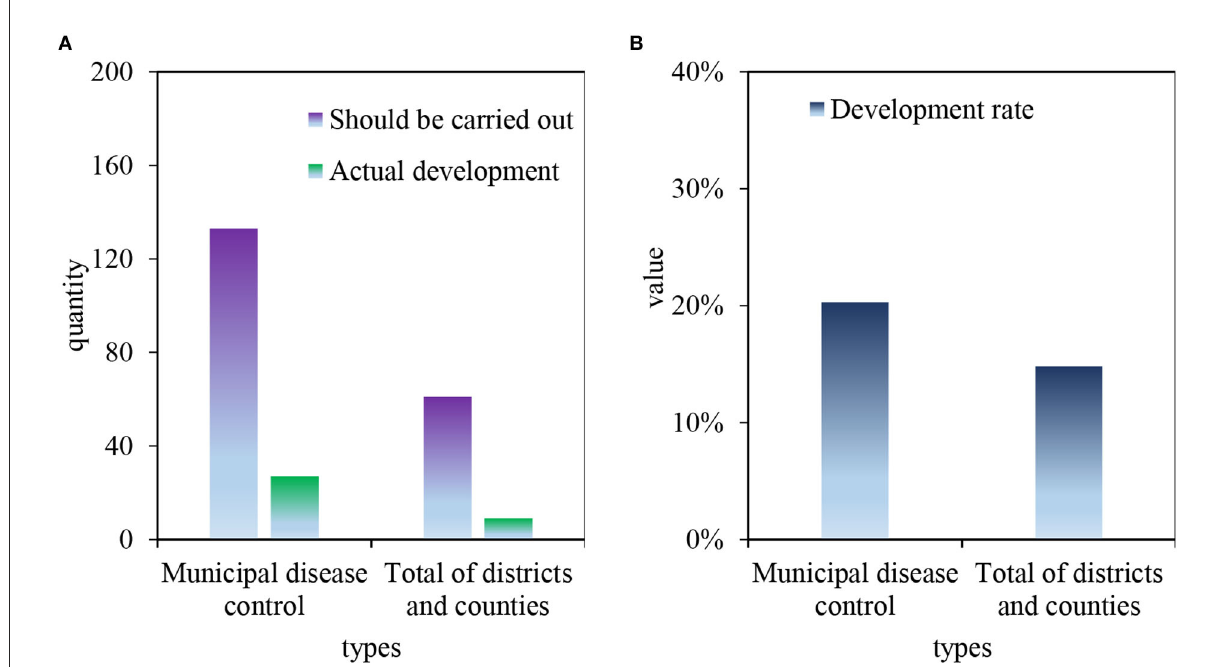
FIGURE7 Work items to be carried out by disease control institutions in M City according to regional characteristics and needs. (A) The work items that the disease control agency of M City needs to carry out according to the regional characteristics. (B) The implementation rate of the work items that the disease control agency of M City needs to carry out according to the regional characteristics.